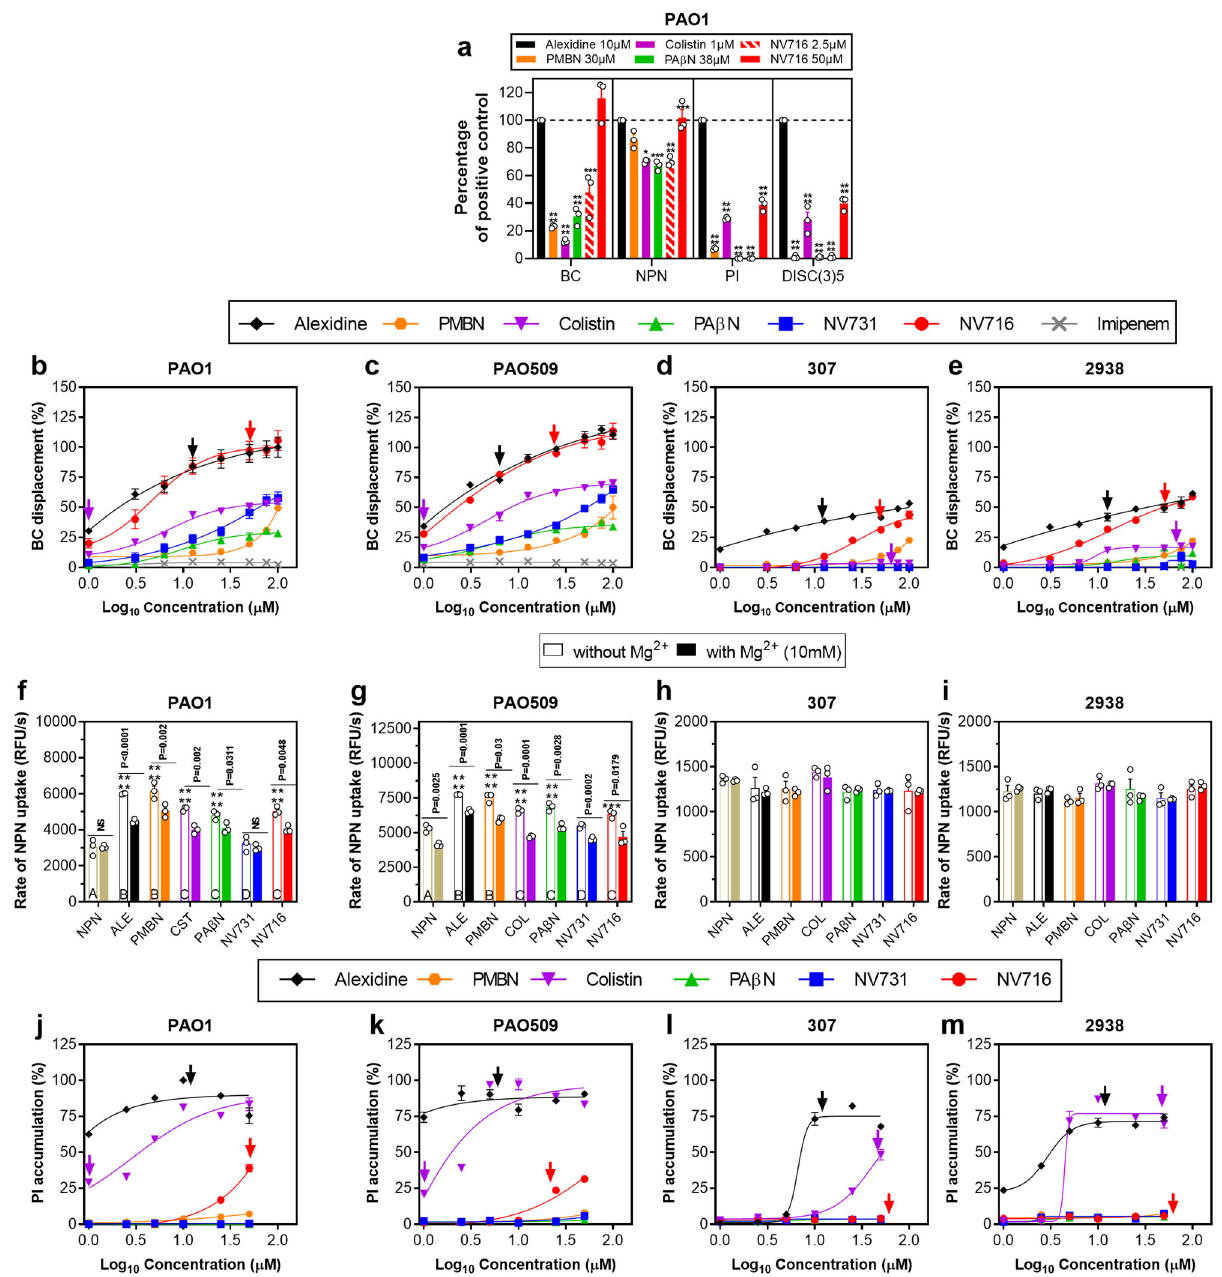
Fig. 3 Effect of potentiators on membrane properties of the 2 reference strains PAO1 and PAO509 and 2 colistin-resistant clinical isolates PA2938 and PA307. a Summary of the effect of potentiators at fi xed concentrations (alexidine [ALE], 2.5 µ M; polymyxin B nonapeptide [PMBN]: 30 μ M; colistin [CST], 1 µ M (MIC against PAO1); PA β N: 38 μ M; NV716: 2.5 μ M and 50 µ M [MIC against PAO1]) on membrane properties of PAO1 (BC: Binding to LPS, assessed by measuring the displacement of BODIPY-cadaverine after incubation during 30 min; NPN: Effect on outer membrane permeability, assessed by measuring the rate of 1- N -phenylnaphthylamine (NPN) uptake at early-time points (0-4 seconds); PI: Effect on inner membrane permeability, assessed by measuring the fl uorescence of propidium iodide (PI) after 1 h of incubation; DISC(3)5: Inner membrane depolarization, assessed by measuring the DiSC3(5) fl uorescence after 15 min of incubation. Values are expressed in percentage of the effect of alexidine. Statistical analysis: one-way ANOVA with Tukey post-hoc test: **** p < 0.0001. b – e concentration-response for BC displacement (Imipenem: negative control). f – i NPN uptake (PA β N: 38 μ M; polymyxin B nonapeptide [PMBN]: 30 μ M; alexidine [ALE], colistin [CST], NV731, NV716: 2.5 μ M), in the absence (open bars) or in the presence (closed bars) of 10 mM Mg 2 + . Statistical analysis: one-way ANOVA with Tukey post-hoc test comparing NPN uptake in all conditions: open bars with different letters are different from one another. One-way ANOVA with Dunnett ’ s post-hoc test for comparison between NPN uptake alone (as a control) or combined with each of the potentiator: *** p < 0.001; **** p < 0.0001. Two-tailed Student ’ s t test for comparison for each condition without and with Mg 2 + : p value indicated above each pair of columns. j – m concentration-response for PI fl uorescence. The effect measured with 0.5 % SDS (w/v) after 1 h was taken as 100% (positive control). All data are means± SEM (triplicates from 3 independent experiments). In panels b – e and j – m , the arrows point to the MIC of the corresponding compound (see Supplementary Table 1; when not shown, the MIC is higher than the highest concentration